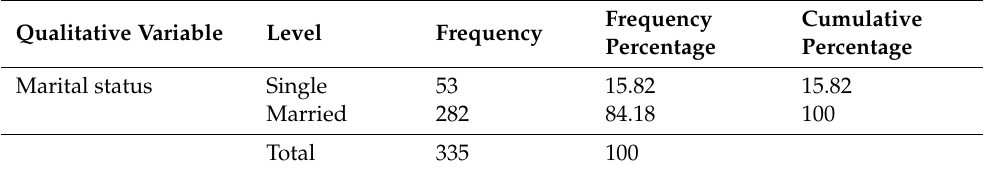
Table 29. Frequency distribution of marital status in the sample.